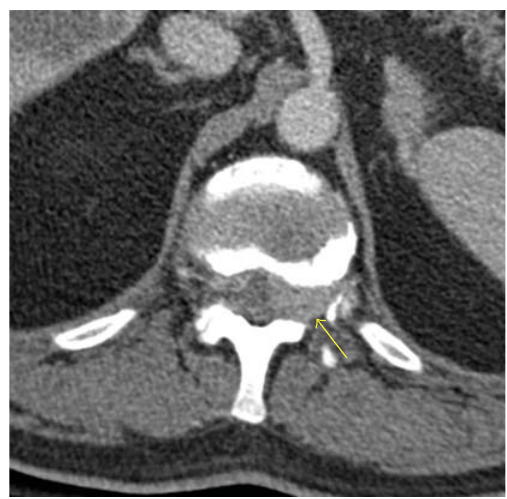
Figure 4: Axial CT in soft tissue algorithm displays slightly hyper- dense soft tissue in the ventrolateral epidural space filling the left neural foramen (yellow arrow) and causing mass e ff ect on the thecal